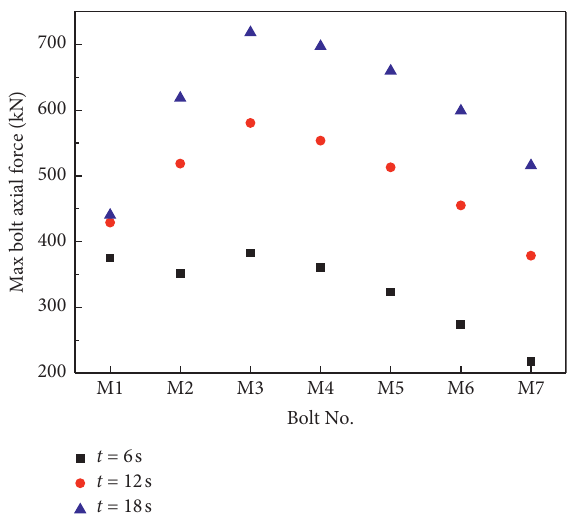
Figure 13: Maximum axial force of bolts at different